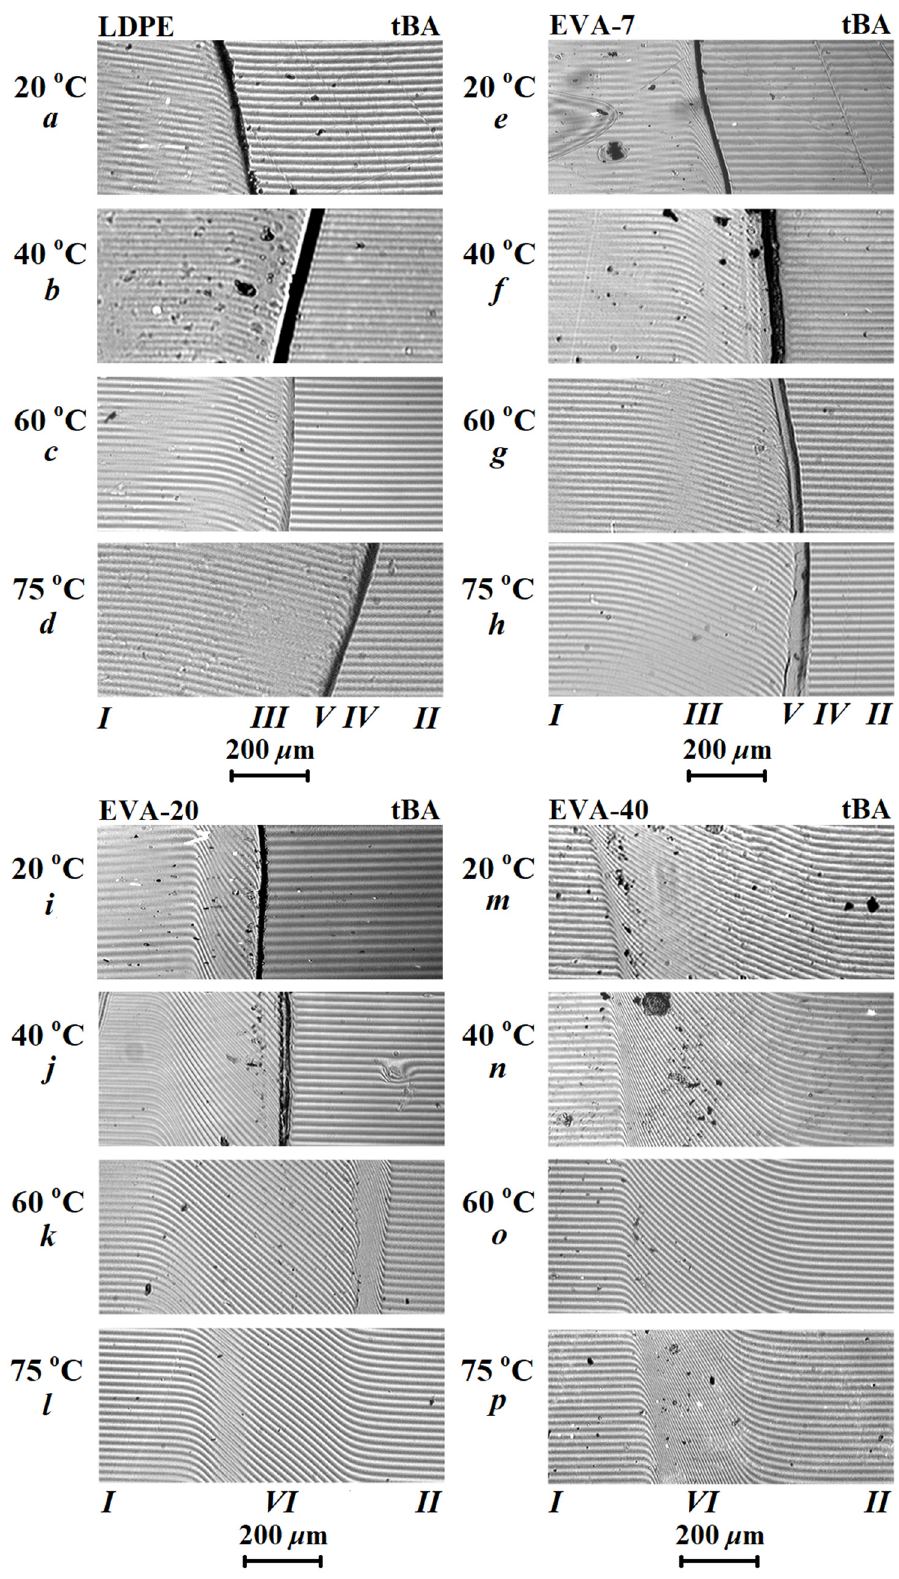
Figure 3. The effect of temperature and VA content in the copolymer on the character of interferograms in the tBA-modifier systems. VA concentrations: 0 wt.% ( a – d ), 7 wt.% ( e – h ), 20 wt.% ( i – l ), and 40 wt.% ( m – p ). The temperature is shown near the interferograms. Diffusion times range from 2 to 16 min, depending on temperature and composition.